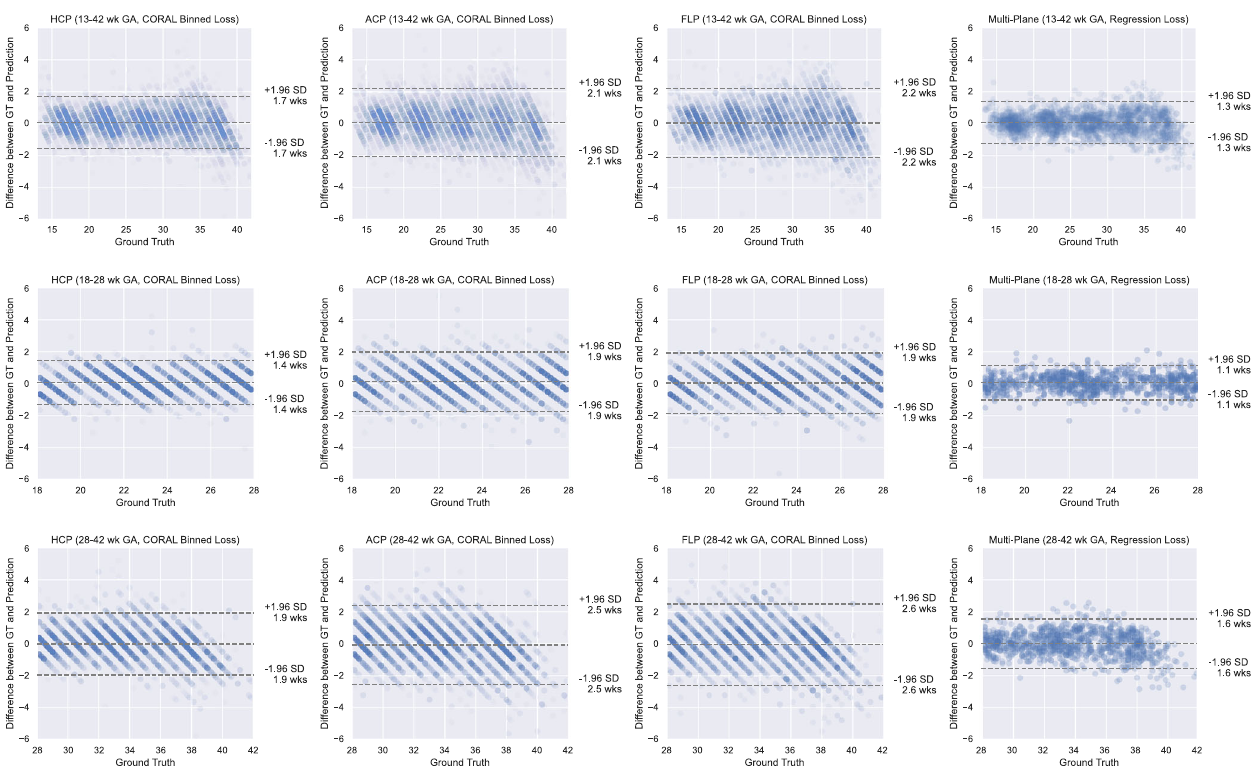
Fig. 3 Modi fi ed Bland-Altman plots showing per plane performance on the INTERGROWTH-21st internal validation set. Modi fi ed Bland- Altman plots of the performance of the gestational age (GA) estimation models on the INTERGROWTH-21st dataset. The striations visible on the data points for the single standard plane models are due to the CORAL binning process employed during training, which is removed for the fi nal MultiPlane regression loss. Due to the variation in the number of data points per fi gure, the transparency of each scatter point was normalised so that the overall appearance is normalised. HCP Head Circumference Plane; GA Gestational Age; CORAL Consistent Ordinal RAnk Logits; GT Ground Truth; SD Standard Deviation; ACP Abdominal Circumference Plane; FLP Femur Length Plane.